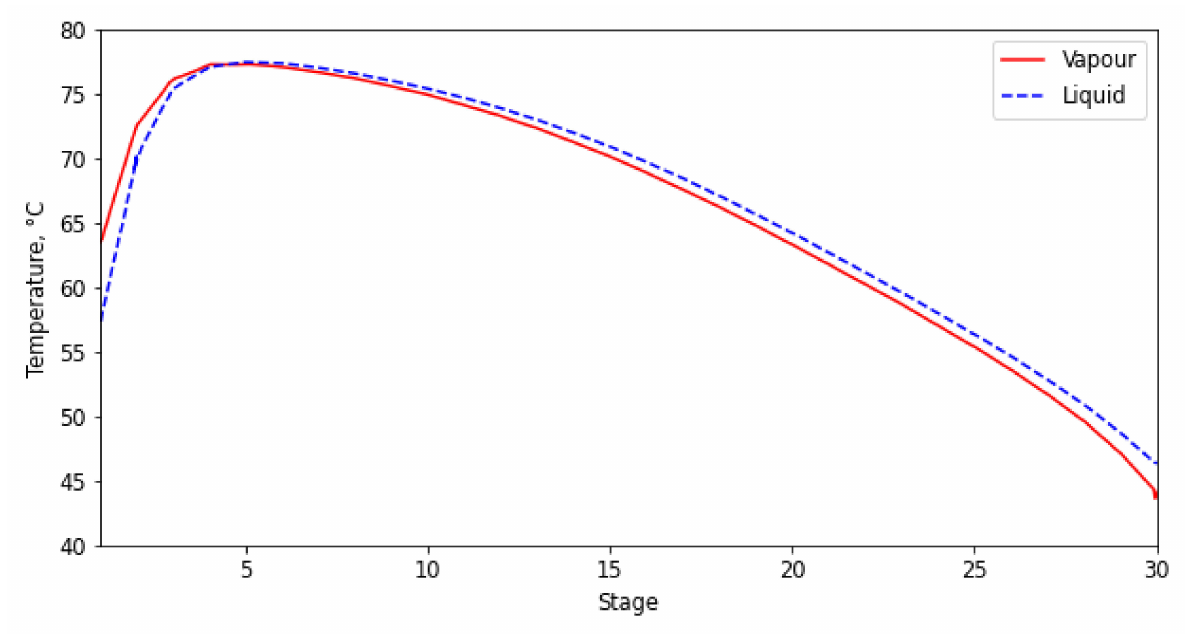
Figure A1. Absorber temperature profile along all stages.